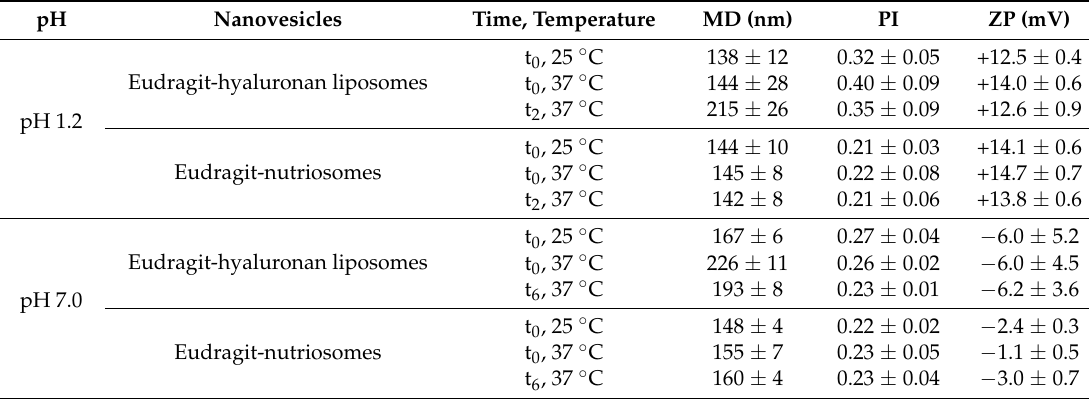
Table 3. Mean diameter (MD), polydispersity index (PI) and zeta potential (ZP) of rehydrated curcumin-loaded Eudragit-hyaluronan liposomes and Eudragit-nutriosomes diluted and incubated at 37 ◦ C in acidic solution (pH 1.2) for 2 h or in neutral solution (pH 7.0) for 6 h, both containing 0.3 M NaCl. The measurements were carried out immediately after dilution (t 0 ) at 25 and 37 ◦ C, and after 2 (t 2 ) or 6 h (t 6 ) of incubation at 37 ◦ C. Mean values of ≥ 3 replicates ± SD are reported.